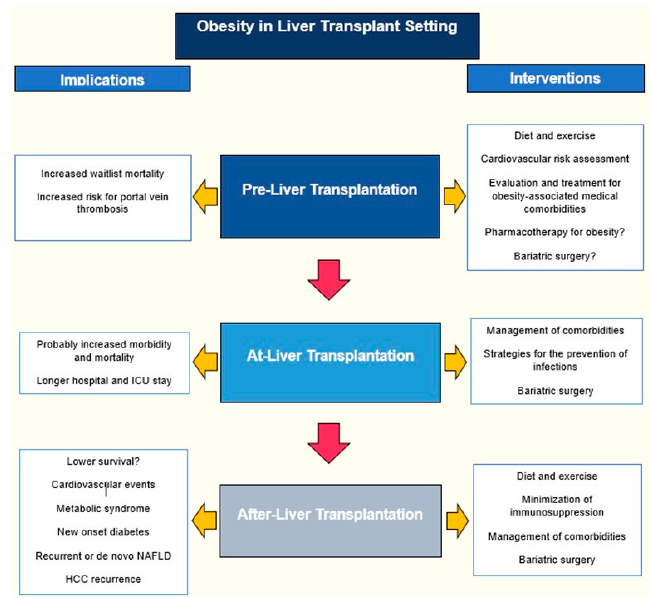
Figure 1. The impact of obesity in the liver transplant (LT) setting. This flowchart illustrates the key elements to consider when assessing a patient with obesity in the context of LT.